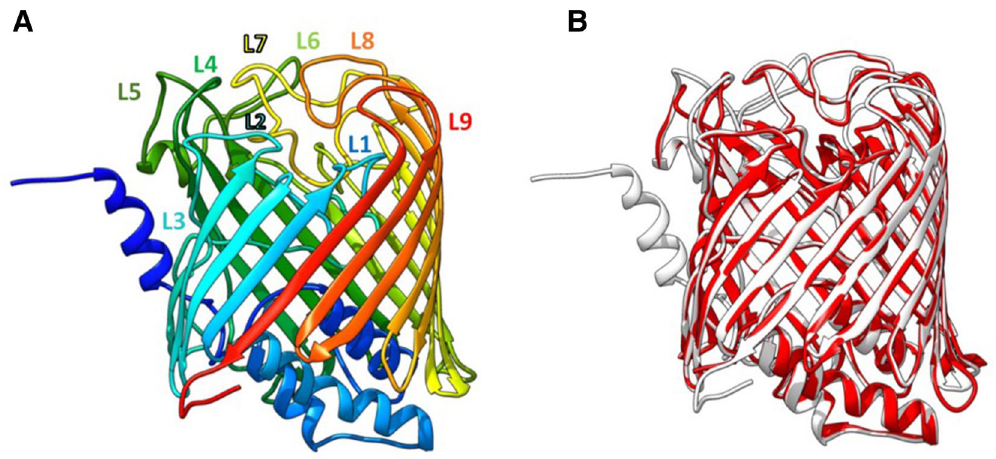
Figure 7. ( A ) Predicted tertiary structure of Wzi type 1 encoded by A. baumannii AB5075-UW showing the location of nine extracellular loops (L1-L9). ( B ) Acinetobacter baumannii AB5075-UW Wzi structure (white) overlaid on E. coli K30 Wzi reference structure (red; PDB: c2ynkA and Bushell et al.